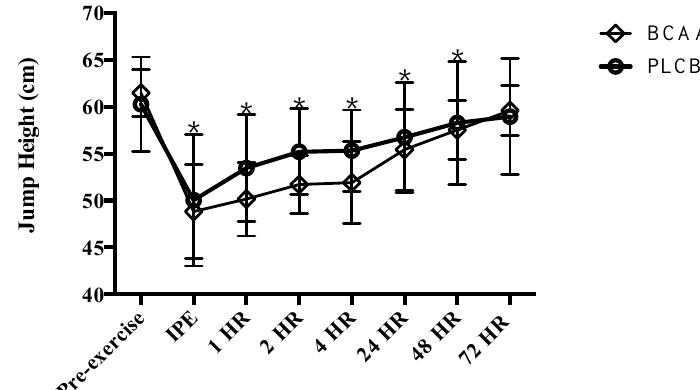
Figure 2. Mean ( ± standard deviation) jump height (cm; centimeters) pre-eccentric exercise, immediate post (IPE), 1, 2, 4, 24, 48 and 72 hours (HR) for resistance trained men supplementing with branched-chain amino acids (BCAA) or placebo (PLCB) ( n = 20). * = significantly different from pre-exercise ( p < 0.05) for both BCAA and PLCB.